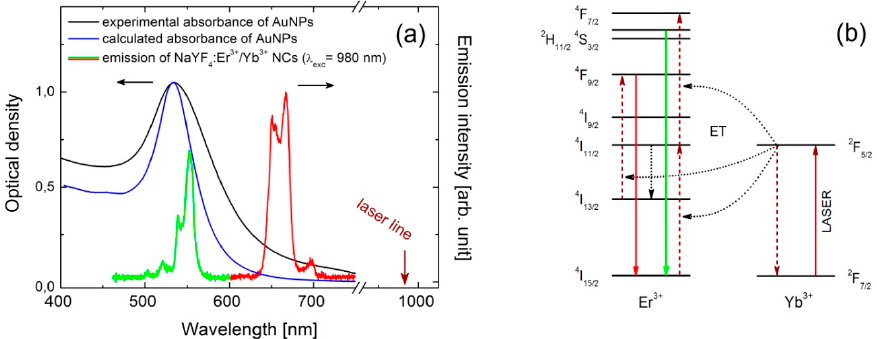
Figure 1. Experimental (black curve) and theoretical (blue curve) absorbance spectra of the colloidal AuNPs together with emission spectrum of the single NC (green/red curve) under 980 nm laser diode excitation ( a ). Energy diagram of the up-conversion transitions observed in the Er 3+ /Yb 3+ system ( b ).